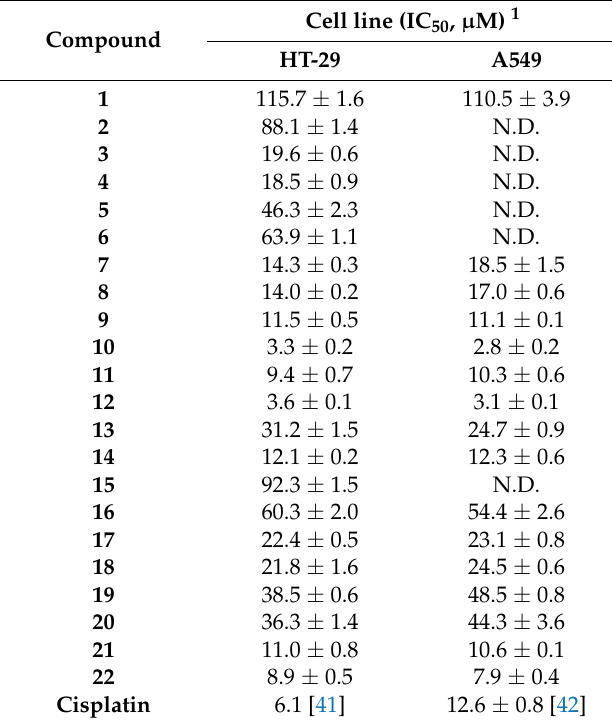
Table 1. Antiproliferative activities of GA, its derivatives, and cisplatin against HT-29 and A549 cell